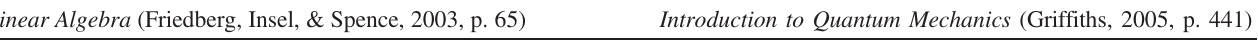
TABLE I. Two definitions of linear transformation . Linear Algebra (Friedberg, Insel, & Spence, 2003, p.